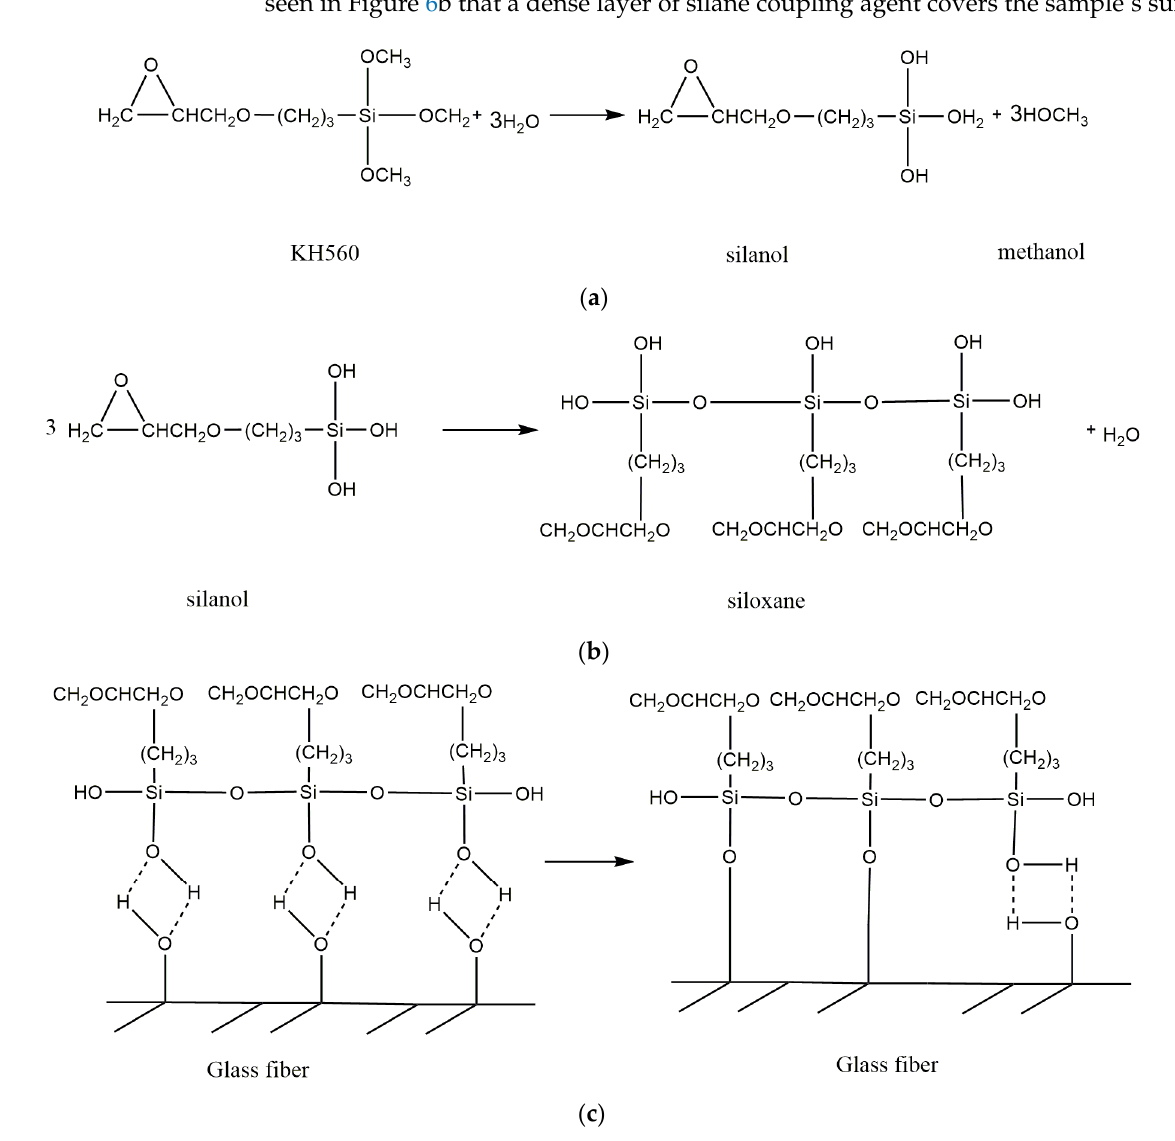
Figure 5. Microscopic morphology of the glass fibre surface ( a ) glass fibre before modification ( b ) glass fibre after modification.